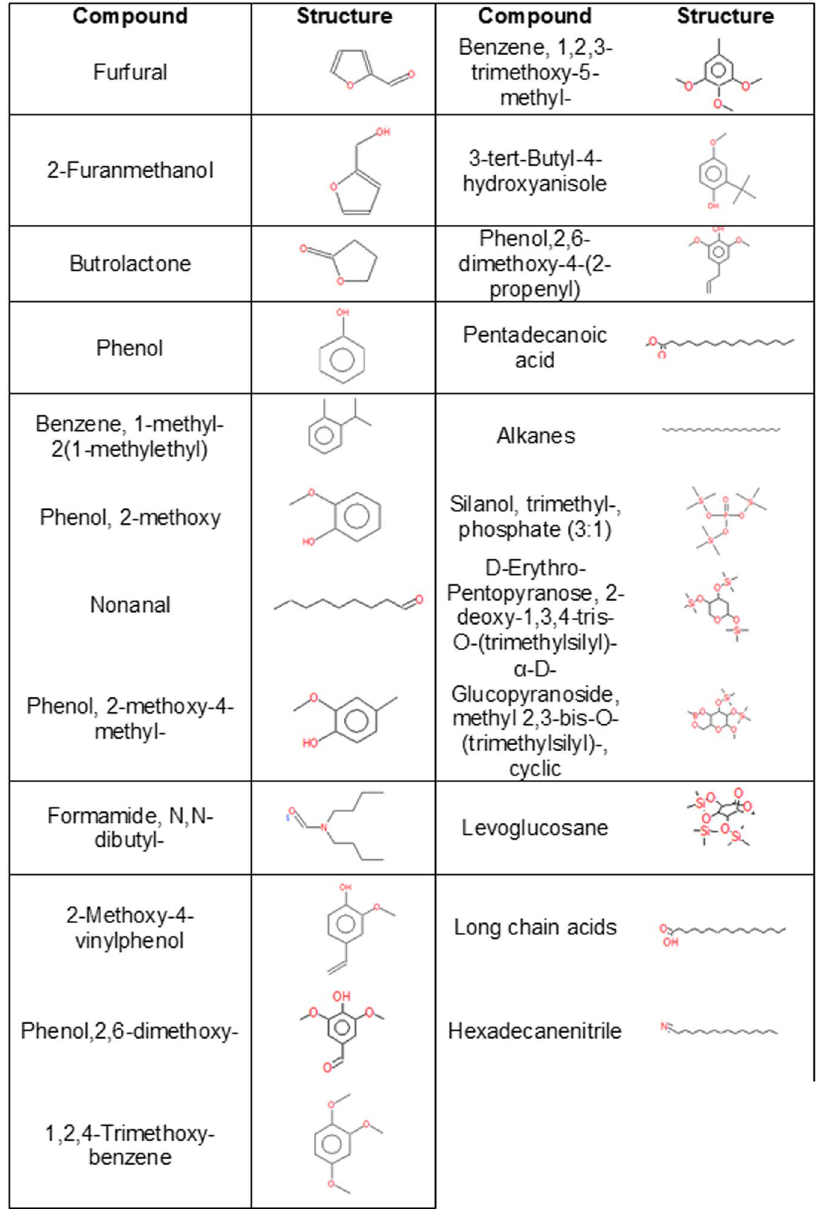
Figure 3. GC/MS Analysis of Dissolved Wood Smoke Compounds. Structural analysis of identified compounds dissolved in the generation of wood smoke